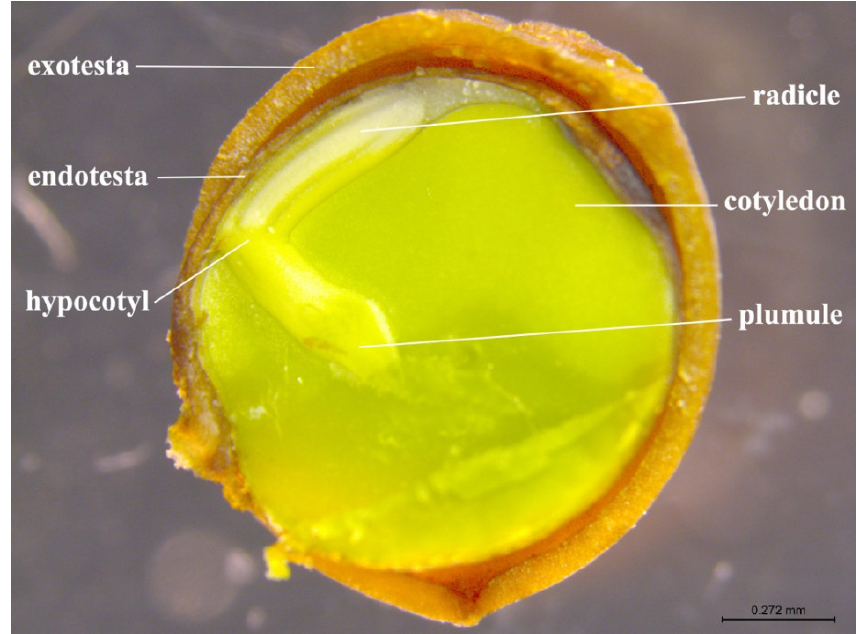
Figure 2. Longitudinal section along the raphe of Chinese pistache seeds.